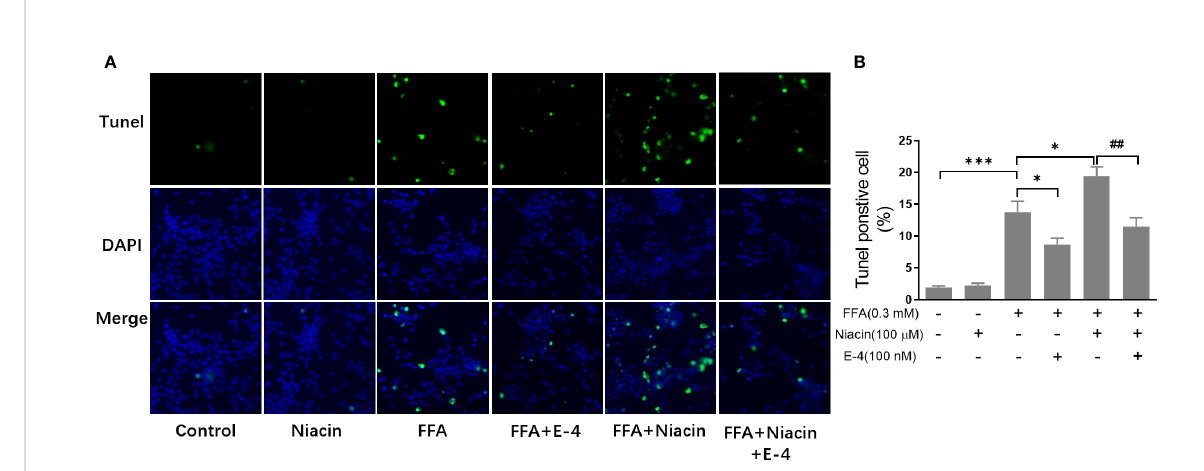
FIGURE 3 Niacin increases FFA induced b cell apoptosis and was alleviated by exendin-4. INS-1 cells were seeded into Millipore ’ s Millicell EZ SLIDE and incubated overnight. Next, the cells were treated with niacin (100 m M) or niacin plus exendin-4 (100 nM) in the absence or presence of 0.3 mM FFA for 24 hours. (A) Representative images of immuno fl uorescence. Green, TUNEL positive cells; blue, 4 ’ ,6-diamidino-2-phenylindole (DAPI). (B) TUNEL positive cells were quanti fi ed and expressed as percentage of total cells. The results are displayed as the means ± SD. n=5, *P < 0.05 and ***P < 0.001 compared to the FFA group; ## P < 0.01 compared to FFA+Niacin group.